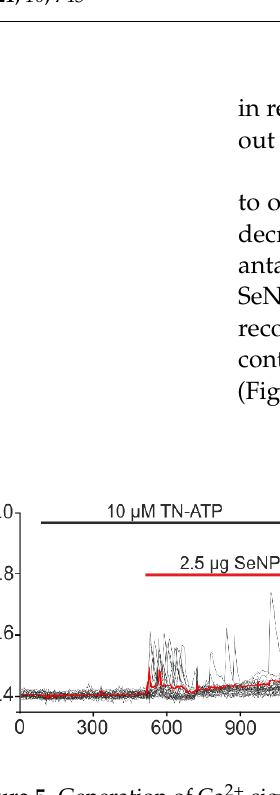
Figure 5. Generation of Ca 2+ signals in A-172 cells in response to the application of 2.5 µg/mL SeNP in the presence of P2X receptors antagonist—TN-ATP ( A , 10 µM), P2Y—receptors-MRS-2179 ( B , 30 µM), and their combined action ( C , 10 µM TN-ATP + 30 µM MRS-2179). At the end of the experiment, 10 μM adenosine triphosphate (ATP) was added. Here, Ca 2+ signals of cells in one experiment and their average value (red curve) are presented.